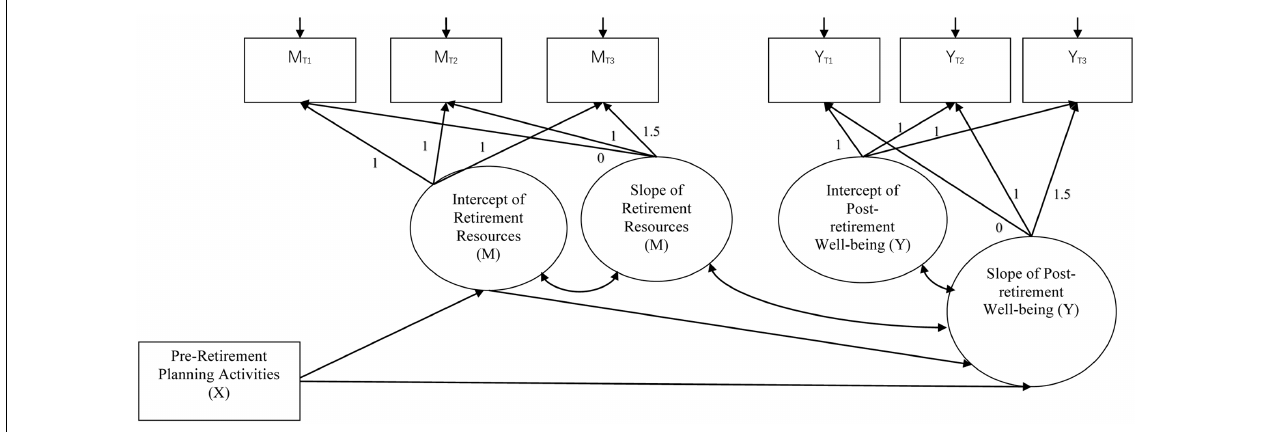
FIGURE 1 | The proposed latent growth mediation model. X denotes the independent variable; M denotes the mediator; and Y denotes the dependent variable. The factor loadings of the intercept of retirement resources and post-retirement well-being were set to 1.0 on the three observed variables of the respective construct in Times 1–3. The factor loadings of the slope of retirement resources and post-retirement well-being were set to [0.0, 1.0, 1.5] on the three observed variables of the respective construct in Times 1–3 to reflect a linear change trajectory over a 1.5-year interval.